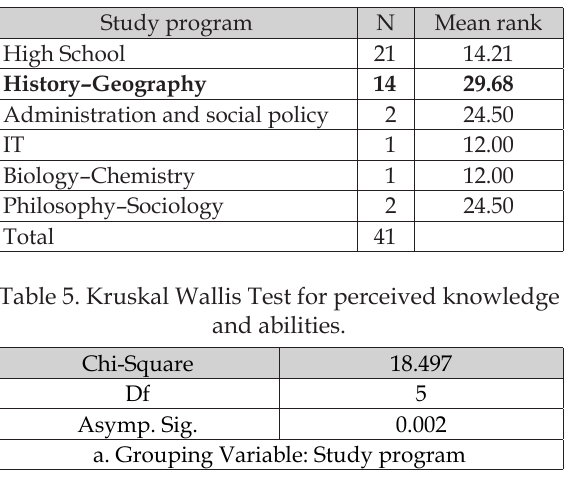
Table 4. Ranks of perceived knowledge and abilities.